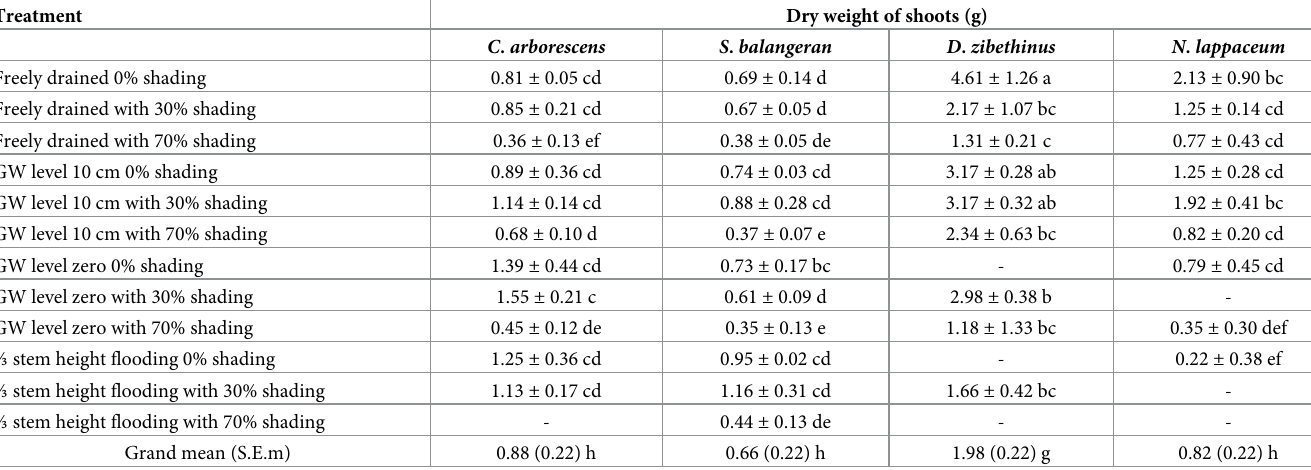
Table 5. Dry Weight (DW) of shoots of four plant species under treatment combination of shading and inundation.